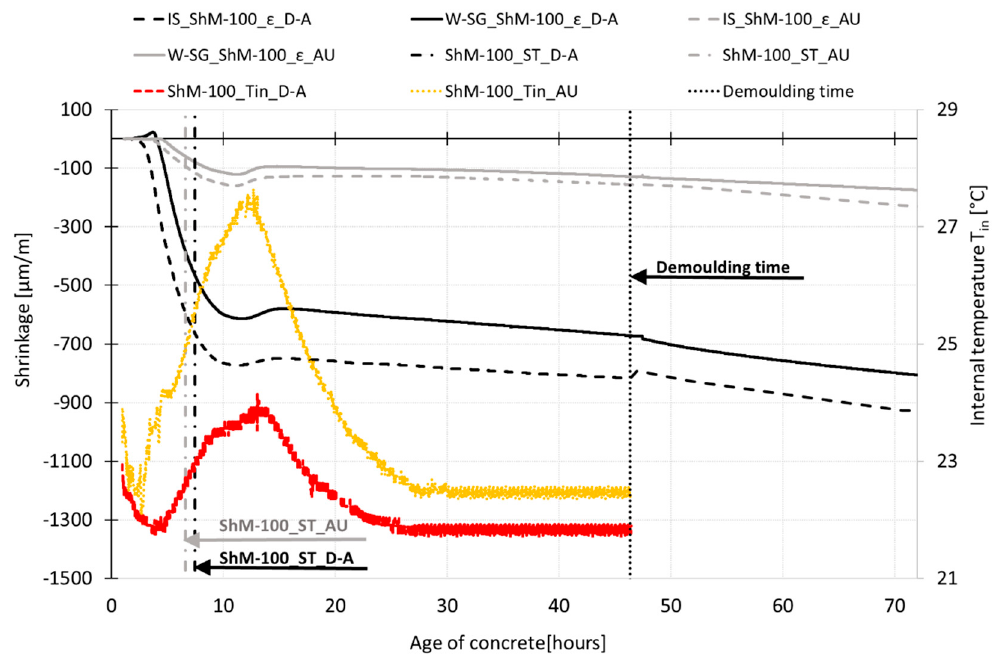
Figure 7. Process of early-age shrinkage recorded by inductive sensor of shrinkage molds (IS_ShM) and embedded strain gauge (W-SG_ShM) of specimens cured under dry air (black lines) and autogenous (grey lines) conditions. The recorded internal temperature (T in ) of specimens (color lines) is also displayed.